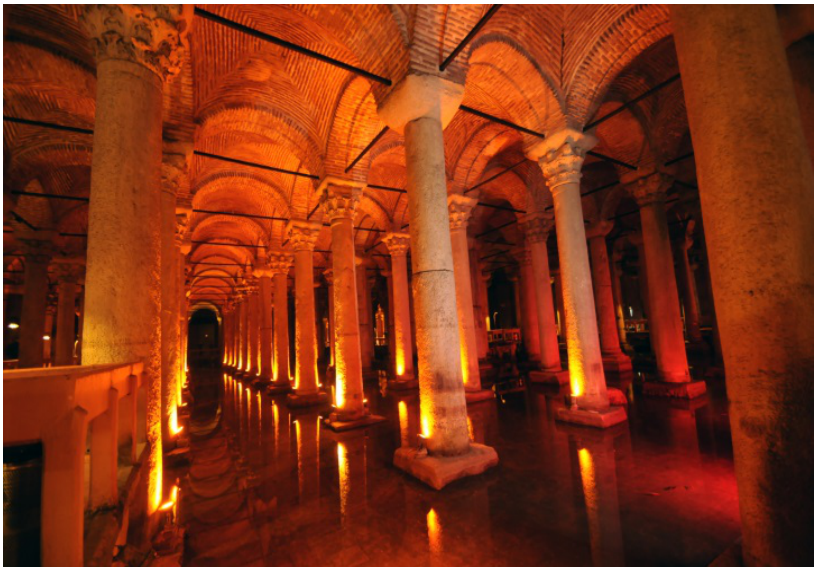
Figure 14. Basilica cistern of Constantinople (photo copyright by L.W. Mays).